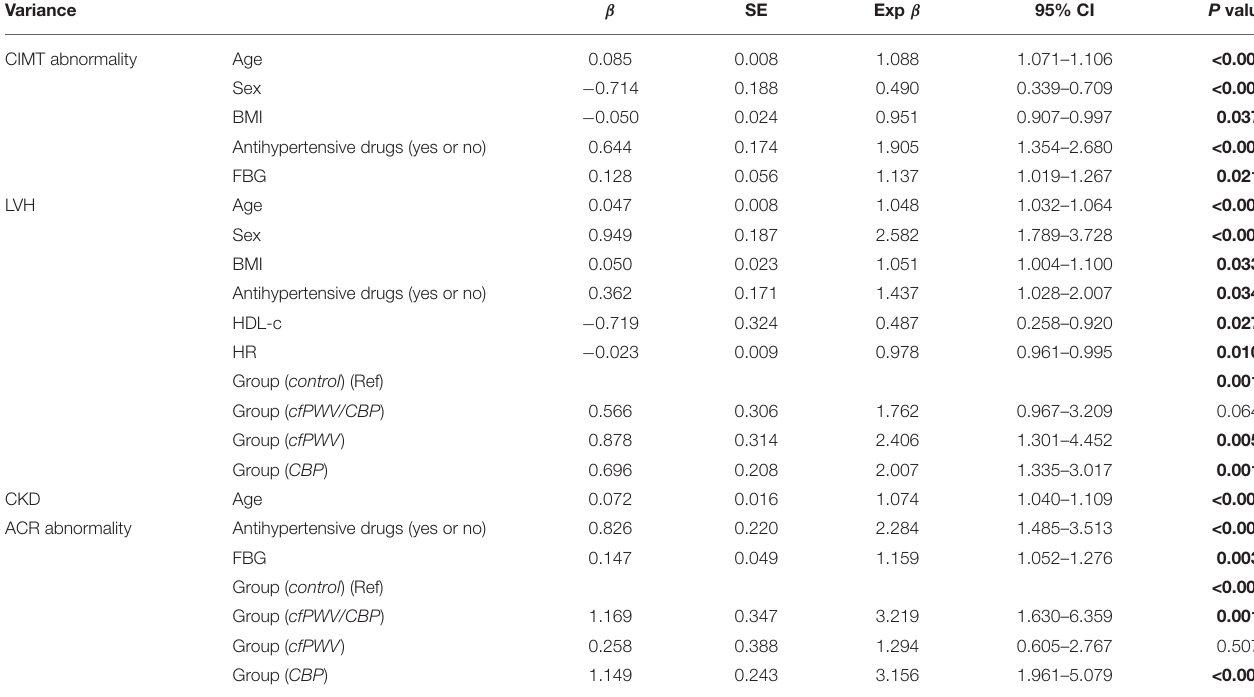
TABLE 4 | Multiple stepwise logistic regression of target organ damage in different groups. Variance